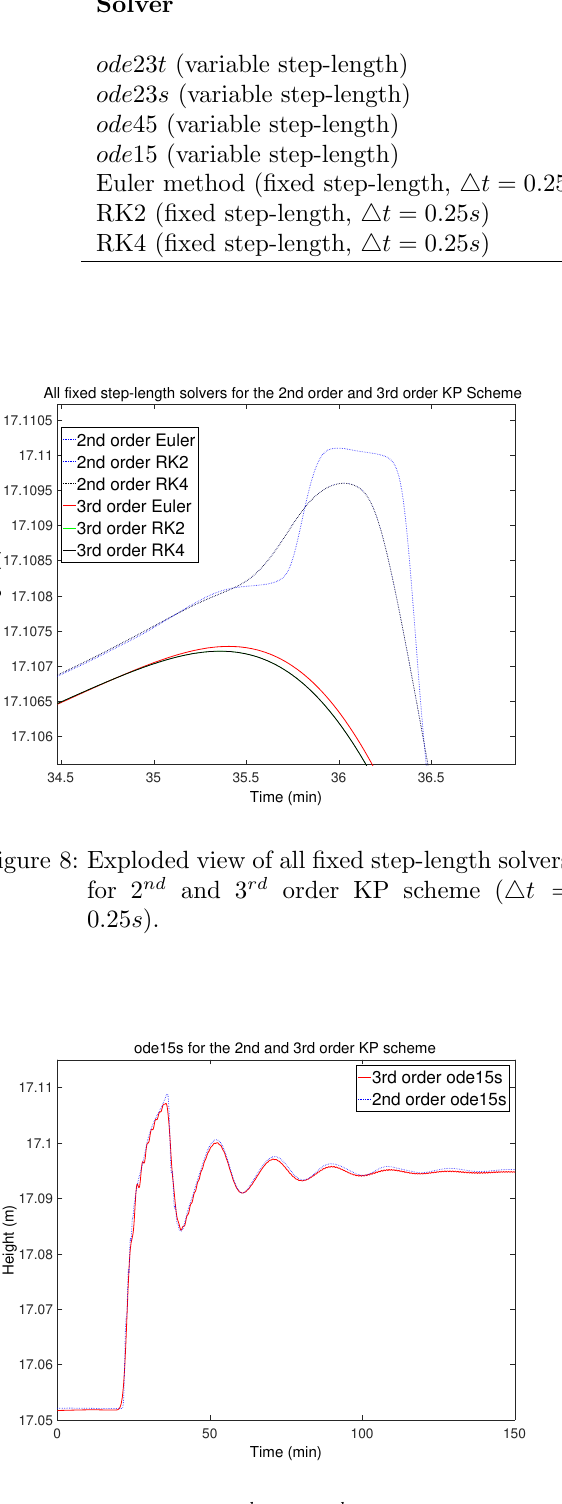
Figure 9: ode15s for 2 nd and 3 rd order KP scheme.